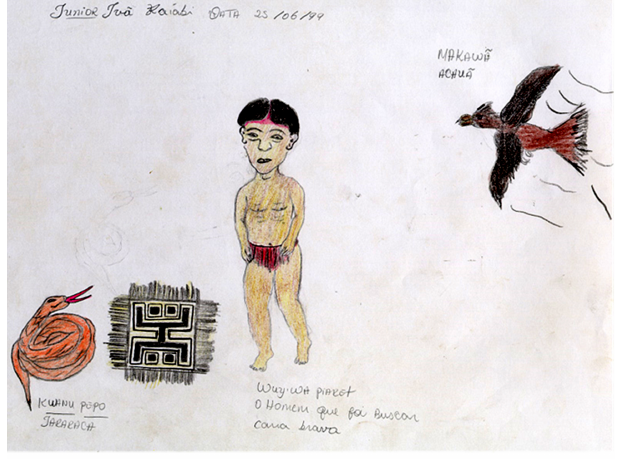
Fig. 3 . Drawing depicting the myth of origin of basketry designs for the Kawaiwete people. The ancestral hero and shaman Tuiararé steals a piece of an anaconda skin, from which he learned how to weave designed baskets and taught the Kawaiwete people. Drawing by Loyvare Jr Kaiabi, Aiporé village, 06/25/1999. Source: adapted from Athayde